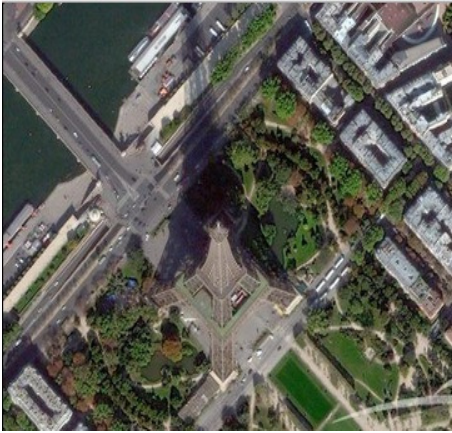
Figure 4: WorldView-2 RGB Image of Eiffel Tower, Paris, France (0.46m)